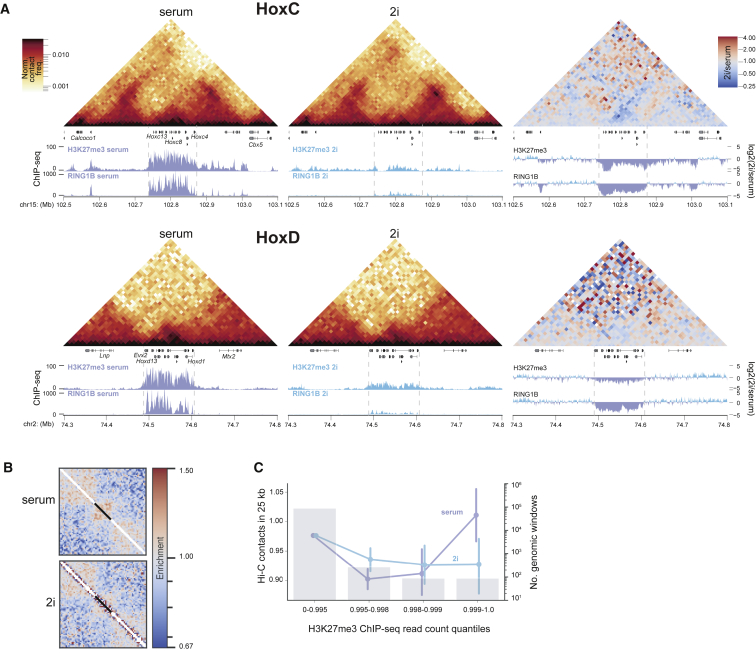
Loss of Local Chromatin Interactions in 2i(A) Hi-C heatmaps (normalized contact frequencies at 10-kb resolution) for cells grown in serum (left) and 2i media (middle) for the HoxC and HoxD clusters. The right-hand heatmaps show the difference between contact frequencies in 2i versus serum. Boundaries of the Hox clusters are marked with dashed lines. Below the gene annotations, ChIP-seq profiles for H3K27me3 (Marks et al., 2012) and Ring1B (Joshi et al., 2015) are shown. Genome coordinates are from mm9 assembly of the mouse genome(B) Local rescaled pileups (Flyamer et al., 2019) of all long (> 10 kb) regions of RING1B binding (n = 181) in serum and 2i Hi-C data. Black bar shows the location of the averaged RING1B binding sites.(C) Mean ± 95% confidence interval (CI) number of normalized local Hi-C interactions (left-hand y axis) in 25-kb windows across quantiles of H3K27me3 occupancy in serum. Data for serum and 2i media are shown as purple or blue dots, respectively. Grey bars show the number of windows in each category (right y axis with log scale).